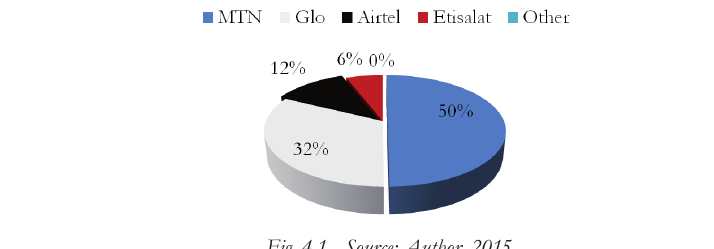
Fig. 4.1 - Source: Author,